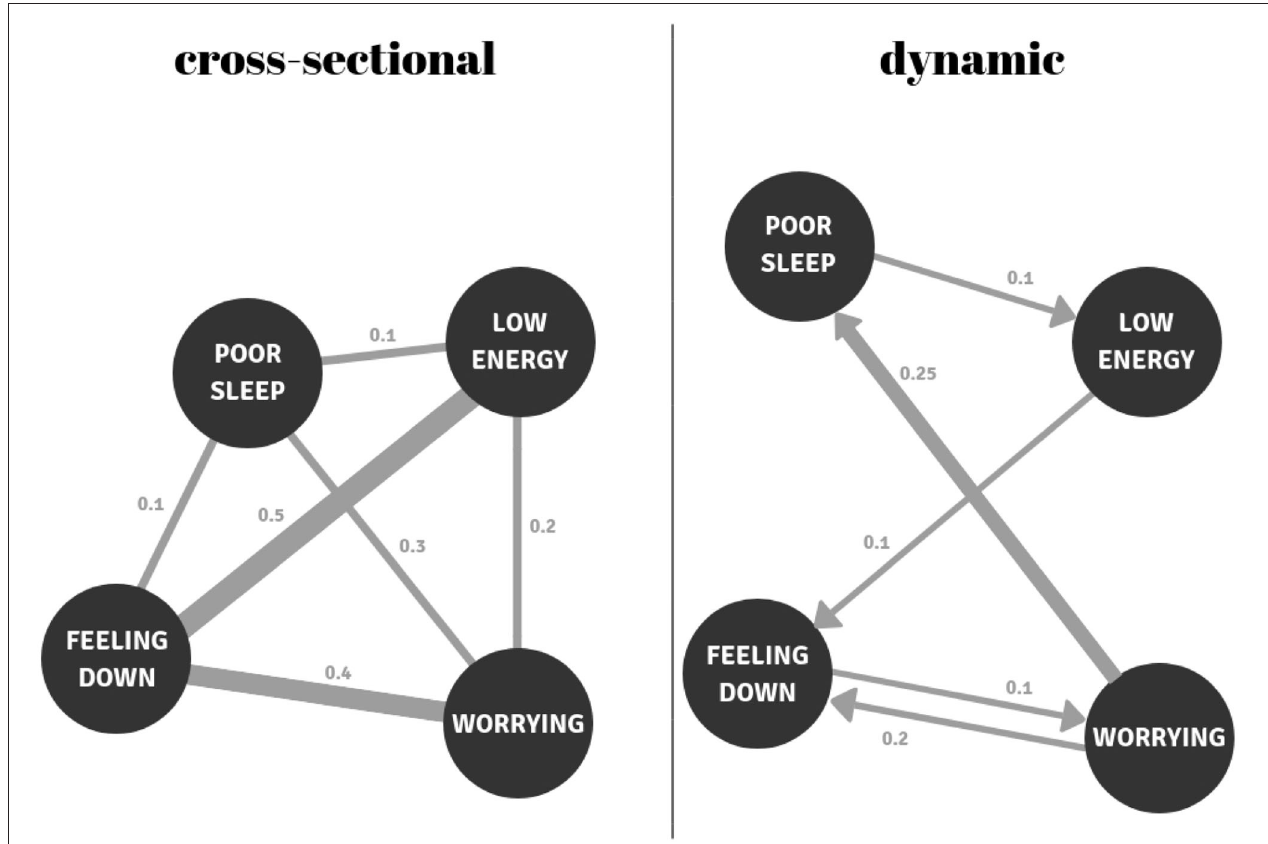
FIGURE 2 | Examples of a cross-sectional and a temporal (dynamic) network. In the cross-sectional network, feeling down is the most central node (0.1 + 0.4 + 0.5 = 1.0); it has the strongest connections with the other nodes. In the temporal network, worry has the highest outgoing centrality; this node most strongly predicts other nodes (0.25 + 0.2 = 0.45). The node with the greatest incoming centrality is feeling down (0.1 + 0.2 = 0.3), because this node is most strongly predicted by other